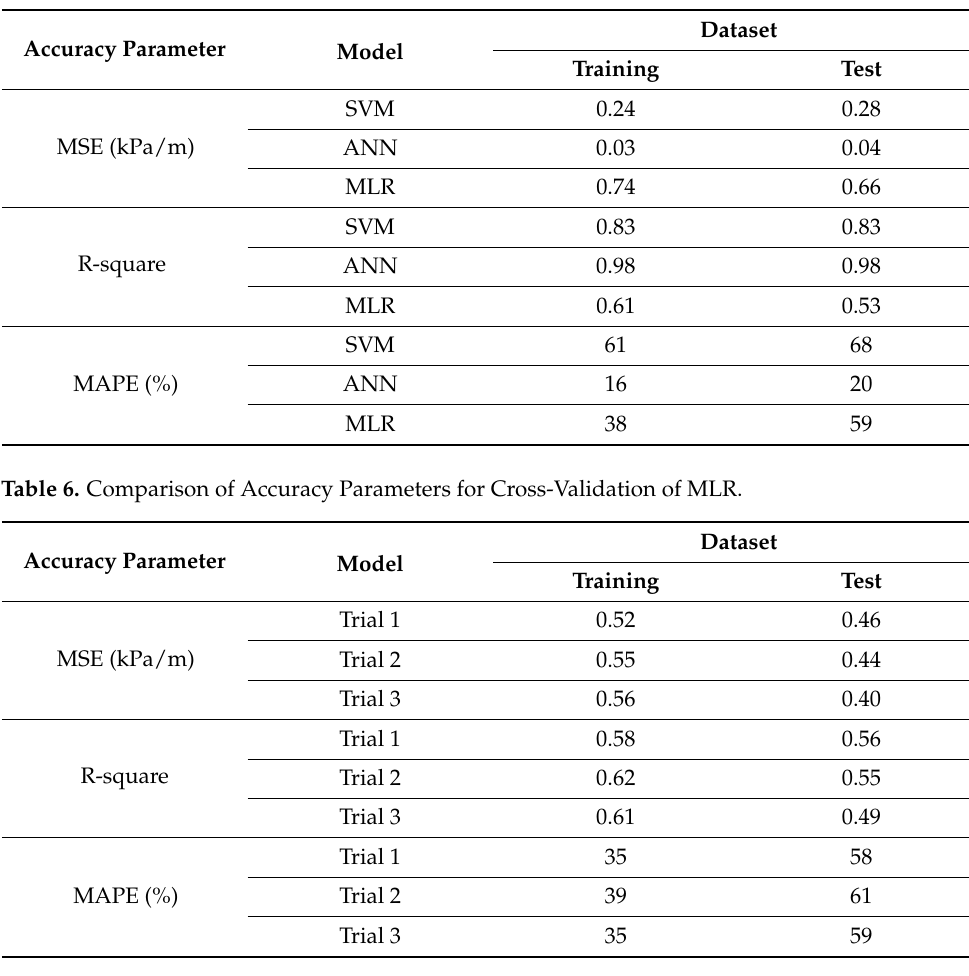
Table 5. Comparison of Accuracy Parameters.